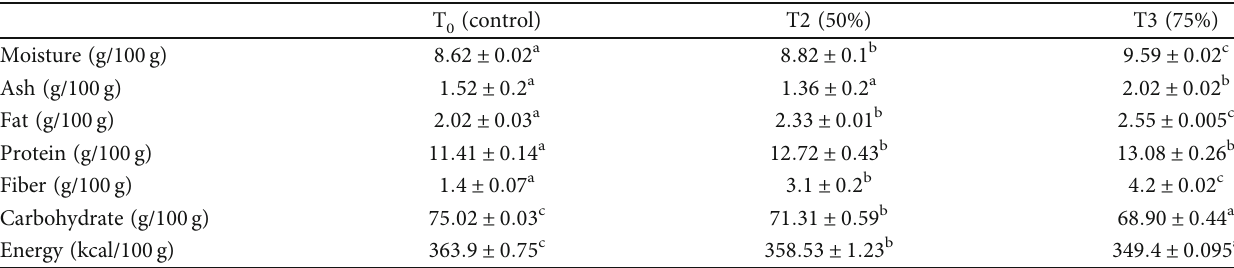
Table 5: Proximate composition of the di ff erent most appreciated